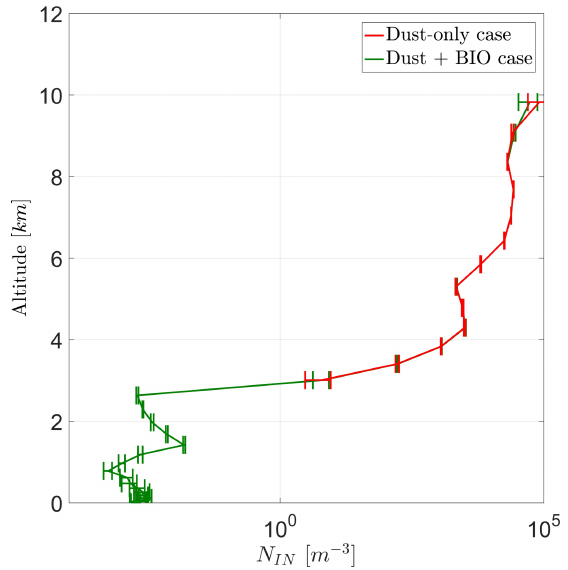
Figure 7. Vertical profile for total prognostic in-cloud INPs ( N IN ) for a case with and without PB-INPs (cases BIO and DST).